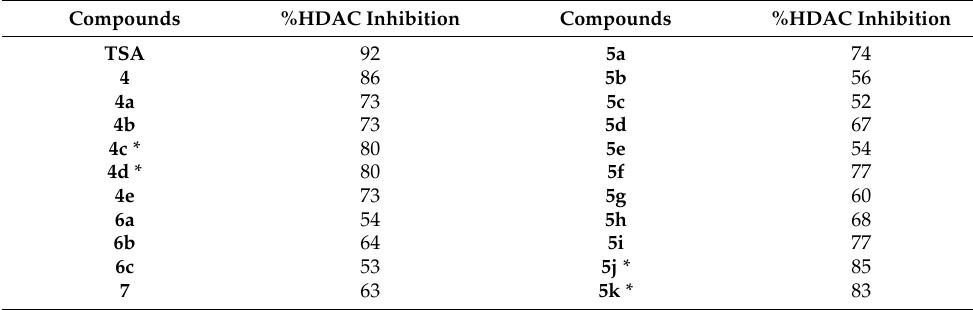
Table 1. HDAC inhibitory activity of compounds at 100 µ